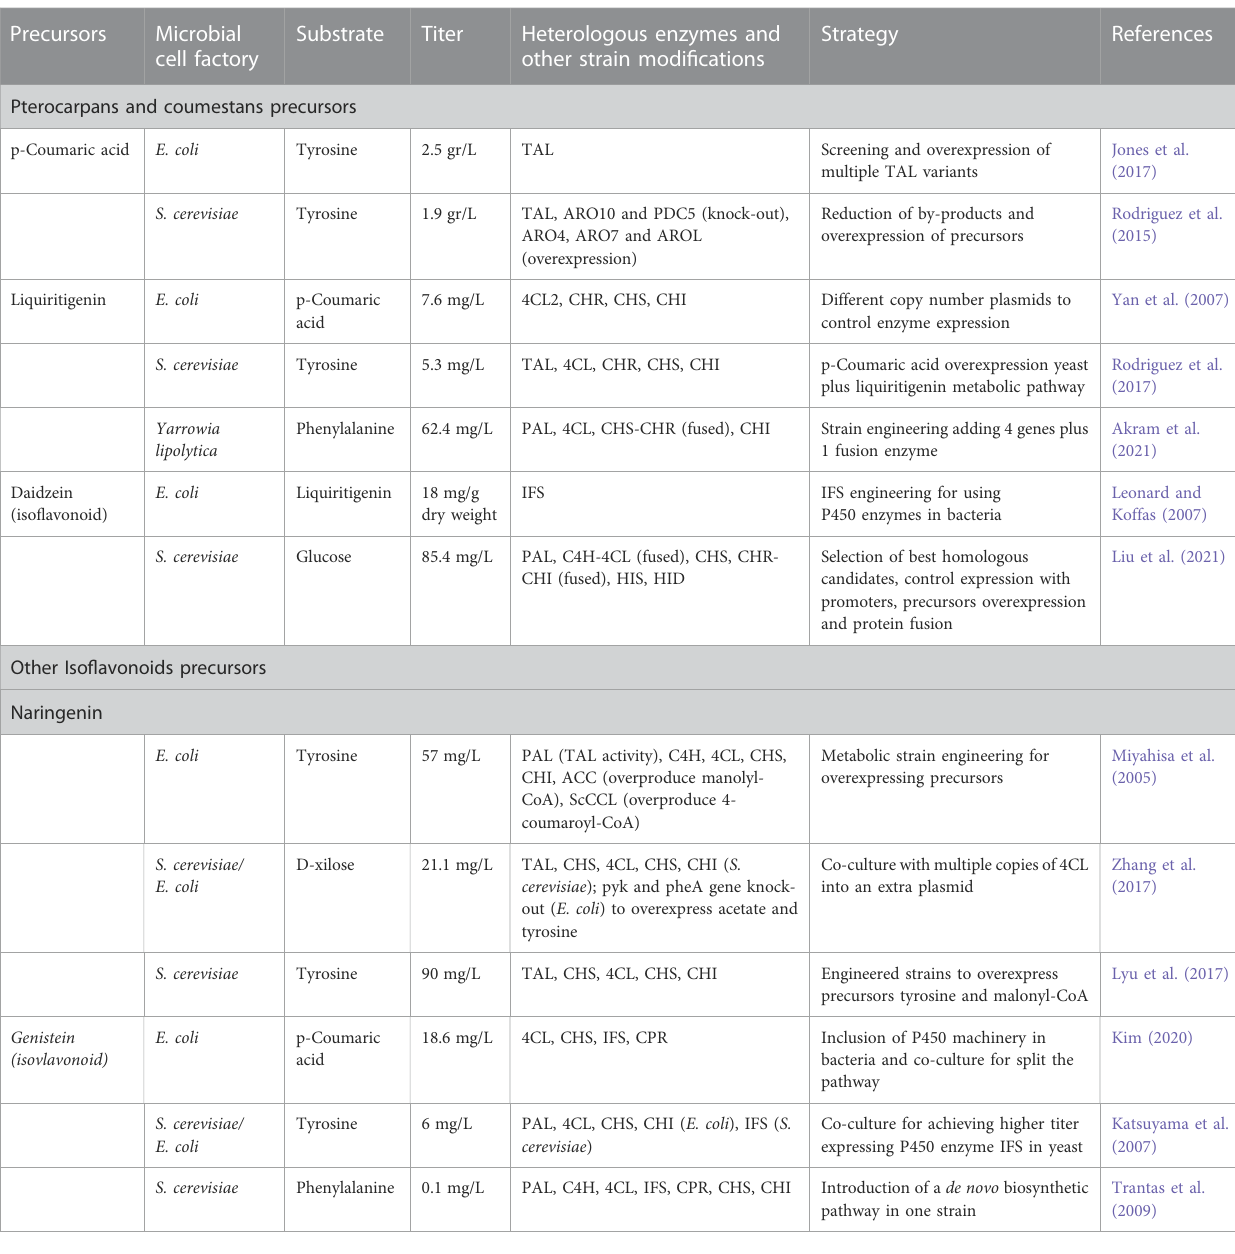
TABLE 3 Successful examples of heterologous biosynthesis of iso fl avonoid precursors using different cell factories. Abbreviations: ARO10, phenylpyruvate decarboxylase; PDC5, pyruvate decarboxylase; TAL, tyrosine ammonia-lyase; ARO4, 3-deoxy-D-arabino-heptulosonic acid synthase; ARO7, chorismate mutase; AROL,shikimatekinaseII;4CL,4-coumaroylCoAligase;CHS,chalconesynthase;CHI,chalconeisomerase;CHR,chalconereductase;IFS,iso fl avonesynthase;HIS,2- hydroxyiso fl avanone synthase; HID, 2-hydroxyiso fl avanone dehydratase; PAL, phenylalanine ammonia lyase; C4H, cinnamate 4-hydroxylase; ACC, acetyl-CoA carboxylase; CCL, cinnamate/coumarate-CoA ligase; CPR, cytochrome P450